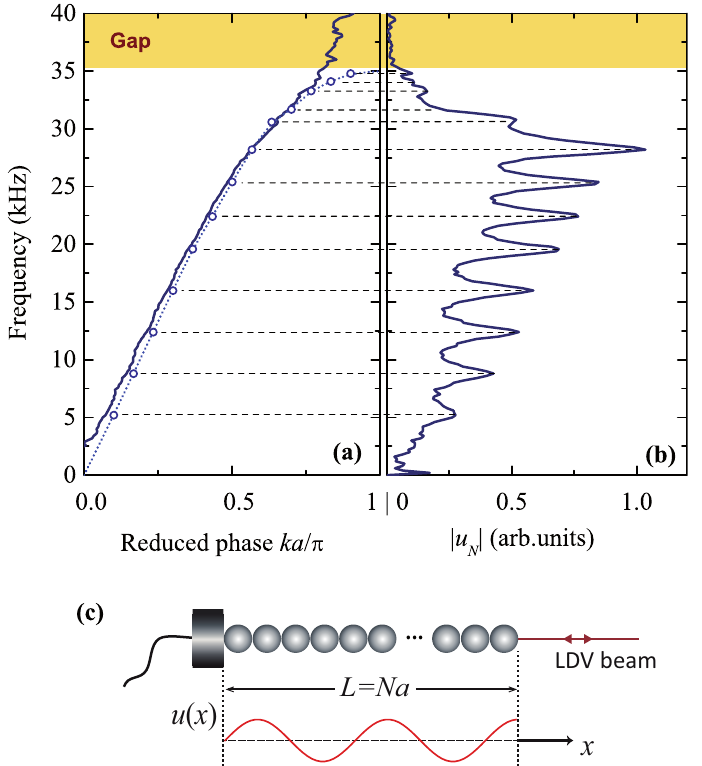
Figure 8. ( a ) experimental dispersion plot of a linear chain of lattice parameter a , made of N touching spheres (diameter d = a = 5 mm) deduced from the FFT phase (solid line) compared to a discrete model description represented by the pairs ( k n a / π , f n ) with n = 0,1, · · · , N − 1 (open symbols). The dotted line is a non-linear interpolation connecting the discrete points ( k n a / π , f n ) , revealing a clear propagative band ranging from 0 to 35 kHz; ( b ) experimental transmitted displacement field spectrum for the case of a finite chain ( N = 15). Horizontal dashed lines are guides to the eye, associating the frequency positions of the FP resonance peaks, f n , to the discrete wavenumbers k n , for the case of N = 15 spheres (see text); ( c ) a schematic representation of the FP resonances in the linear chain configuration with open-closed boundary conditions applied at the extremities of the